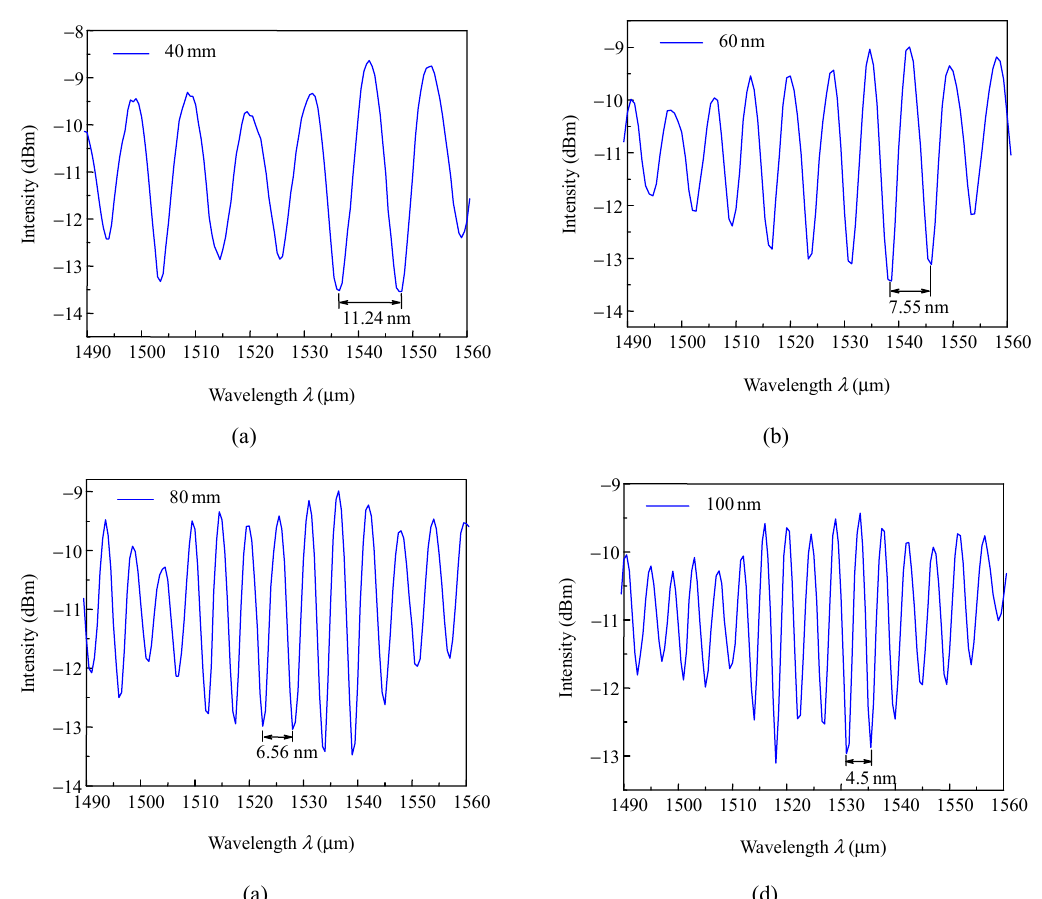
Fig. 5 Simulations of FSR for different lengths of the SMF in the MSM structure: (a) 40 nm, (b) 60 nm, (c) 80 nm, and (d) 100